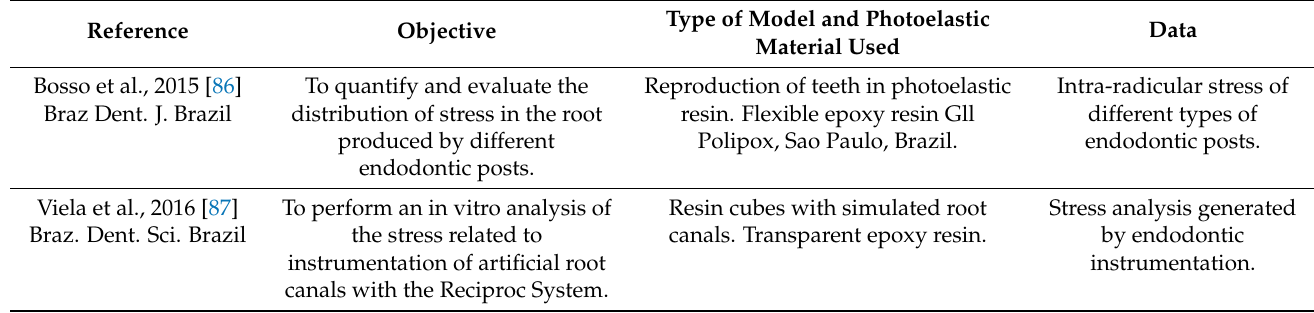
Table 9. Characteristics and findings of studies on endodontics in the dental